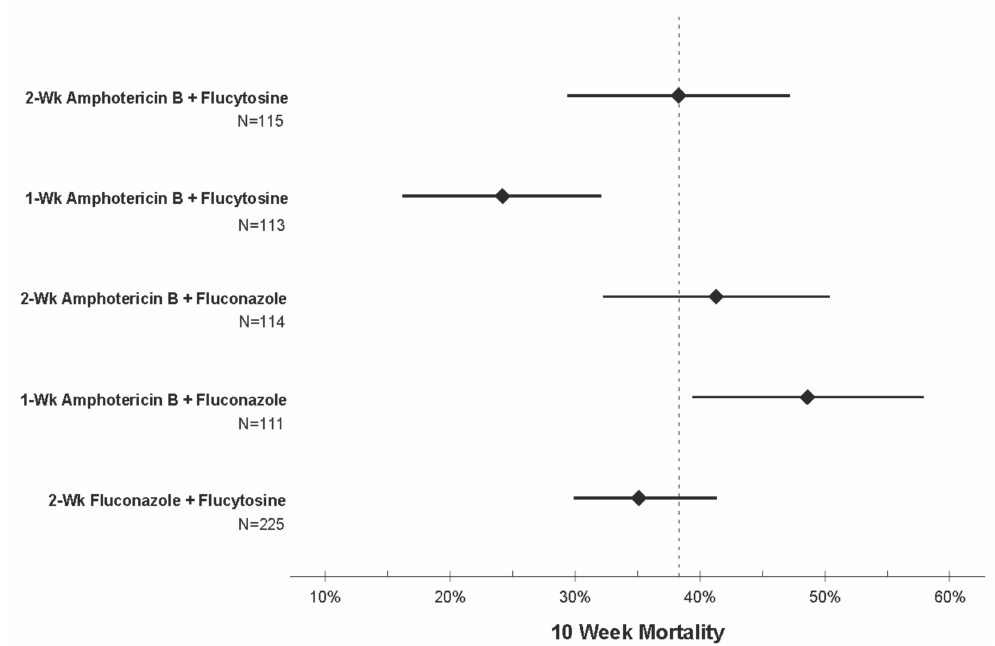
Figure 1. Ten-week mortality by antifungal regimen for cryptococcal meningitis from the Antifungal Combinations for Treatment of Cryptococcal Meningitis in Africa (ACTA) trial [29]. The ACTA trial compared 10-week mortality among five antifungal regimens. The dotted line represents the mean survival of the comparison group (two weeks of amphotericin B plus flucytosine). Mean survival times are noted by the diamonds with the 95% confidence intervals represented by the error bars. One week of amphotericin B with flucytosine demonstrated the lowest mortality of the group, likely due to less amphotericin-related toxicity combined with the improved e ffi cacy of flucytosine over